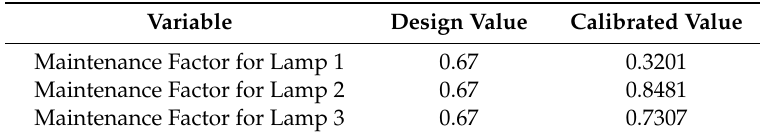
Table 4. Calibration variables of the model.